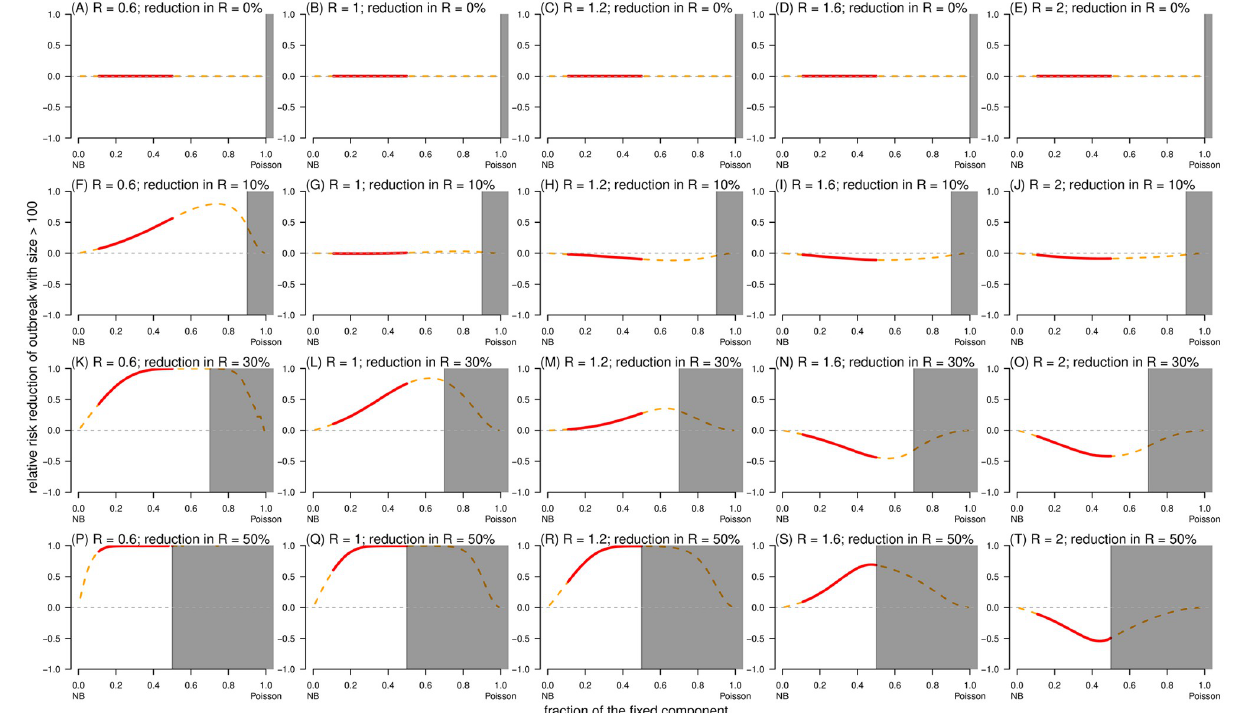
Fig 10. The relative risk reduction, RRR (2,1) ( ξ ), of outcome (II): Outbreak with final size c > 100 under control scheme (II) against scheme (I) as a function of the fraction of fixed component ( ρ ). In each panel, the dispersion parameter k is fixed at 0.2, the shading region indicates the situation that ξ � 1 − ρ , and the bold red segment highlights the range of ρ from 0.1 to 0.5, which characterizes the feature of COVID-19. In each panel label, ‘ R ’ is the reproduction number, and ‘reduction in R ’ is the relative reduction in reproduction number ( ξ ). The horizontal dashed grey line marked the level of RRR = 0. The ‘NB’ in the horizontal axis label stand = s for negative binomial (distribution).